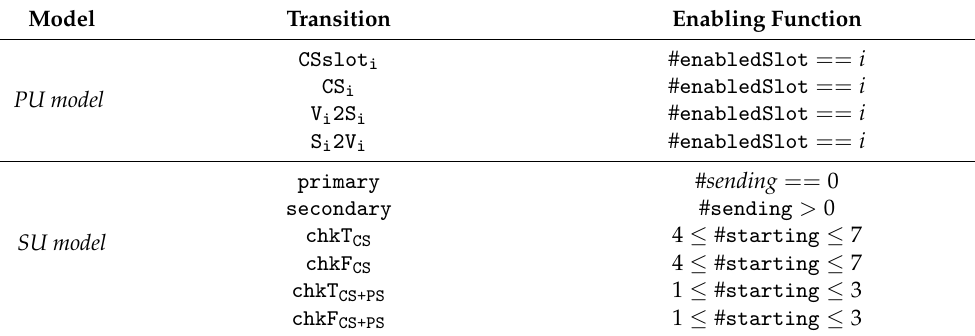
Table 2. Enabling functions used in the NMSPN